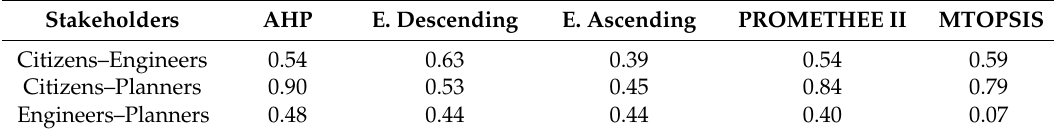
Table 13. Spearman correlation